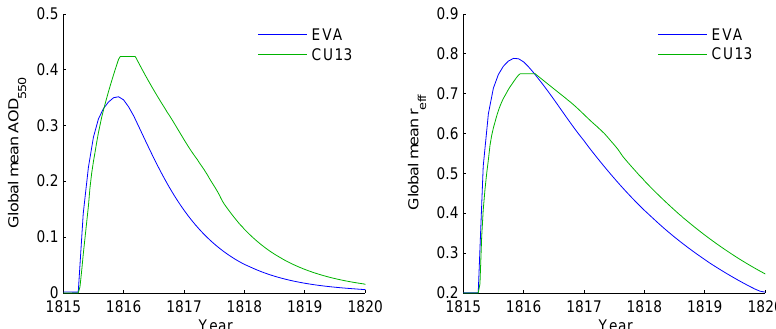
Figure 16. Global mean AOD at 550nm and aerosol effective radius ( r eff ) for the 1815 Tambora eruption from the CU13 reconstruction and EVA.